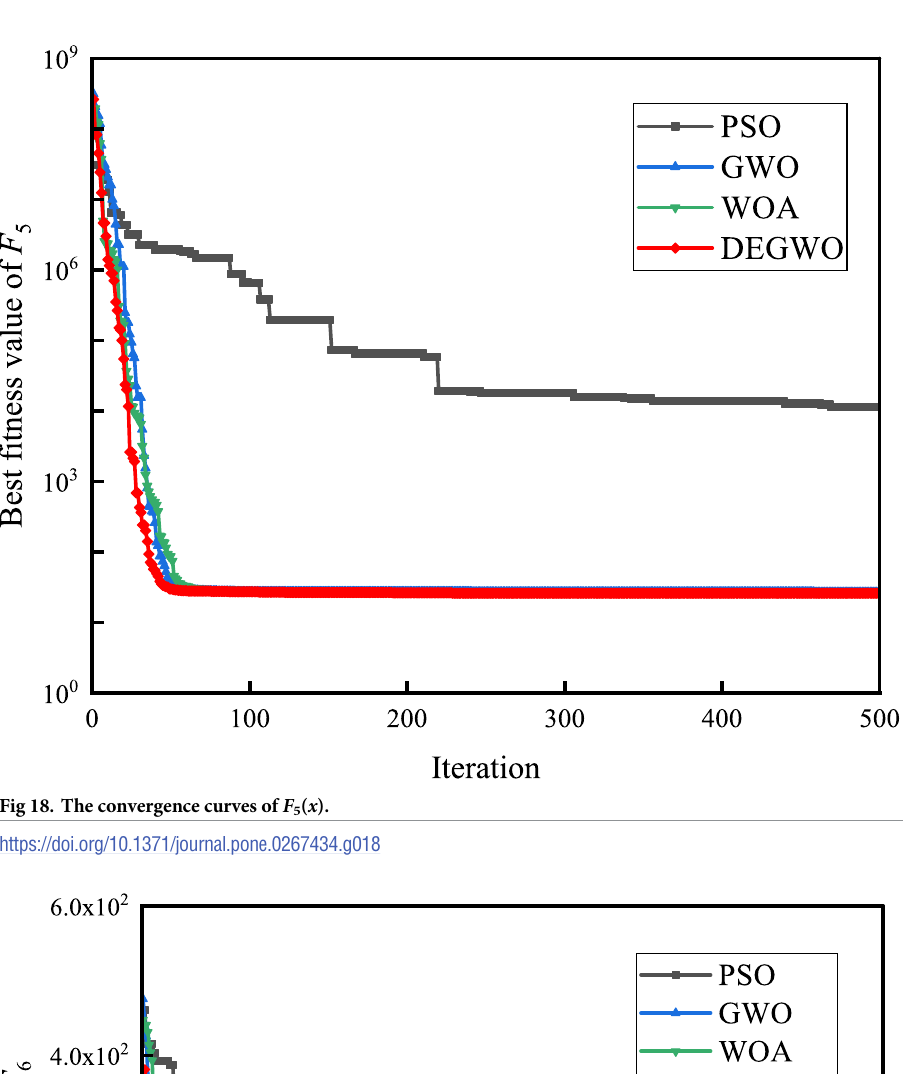
Fig 18. The convergence curves of F 5 ( x ).